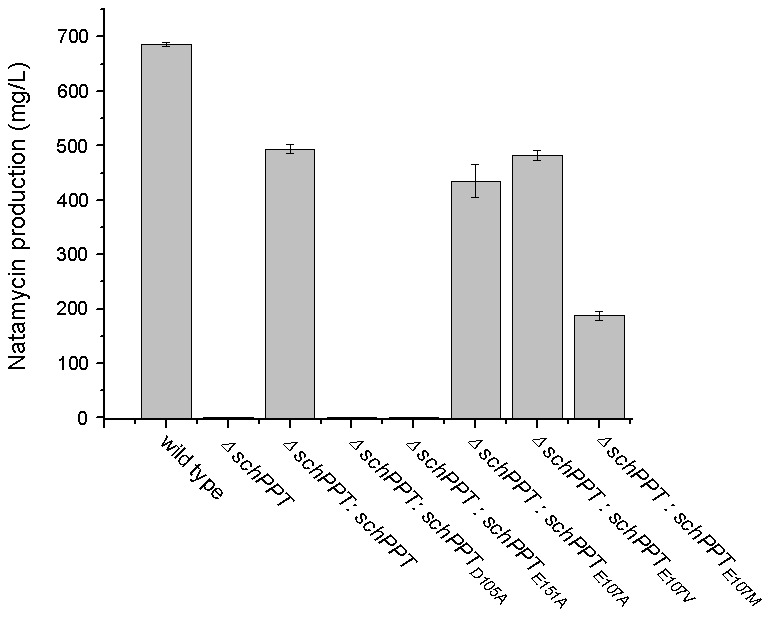
Natamycin production of S. chattanoogensis L10 and its recombinant strains.Wild type (S. chattanoogensis L10), ΔschPPT (sHJ007), ΔschPPT:schPPT (sHJ008), ΔschPPT:schPPTD105A (sHJ009), ΔschPPT:schPPTE151A (sHJ010), ΔschPPT:schPPTE107A (sHJ011), ΔschPPT:schPPTE107V (sHJ012), ΔschPPT:schPPTE107M (sHJ013).